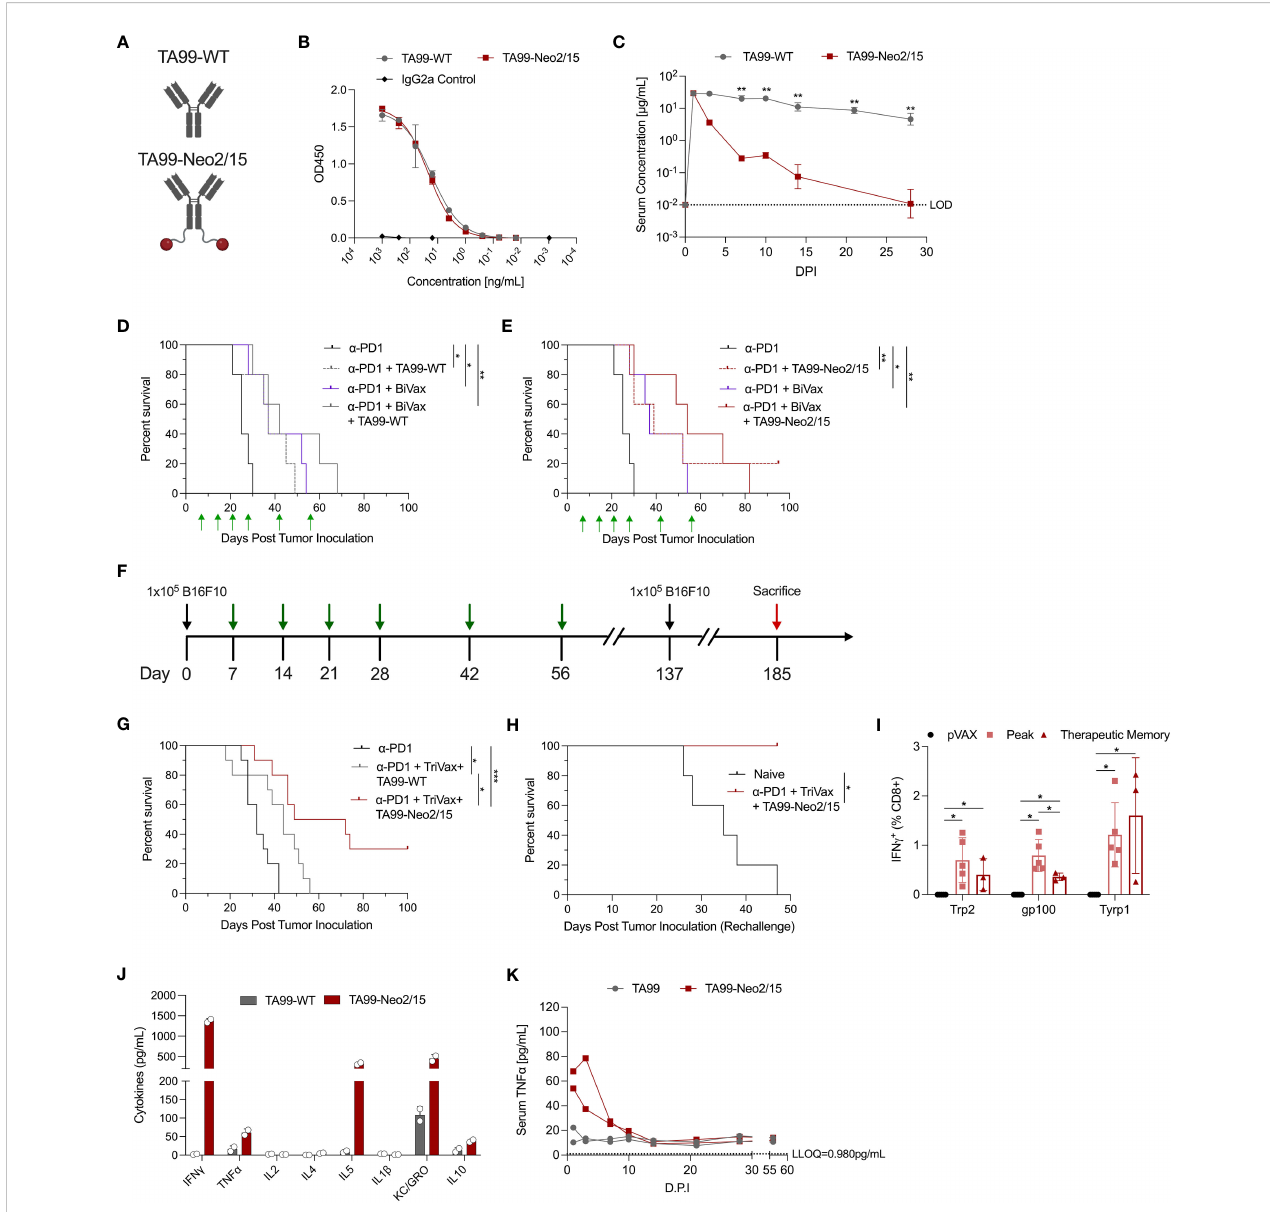
FIGURE 1 Pharmacokinetic and pharmacodynamic characterization of ACC TA99-Neo2/15. (A) Graphical representation of the TA99-WT and ACC TA99-Neo2/15; antibody is shown in grey and neoleukin Neo2/15 shown in red. (B) Binding of recombinant TA99-WT and TA99-Neo2/15 to recombinant human TYRP1 compared to a murine isotype IgG2a control. (C) Pharmacokinetic pro fi les of recombinant TA99-WT and TA99-Neo2/15 antibodies; serum at the indicated timepoints was assessed for TYRP1 binding by ELISA. (D) Survival curves of mice (n=5 per group) post tumor challenge following treatment with anti-PD1 alone (200µg), or anti-PD1 + TA99-WT (50µg), or anti-PD1 + BiVax (10µg each Trp2 and Gp100 DLnano vaccines), or anti-PD1 + TA99-WT + BiVax. 1x10 5 B16F10 cells were subcutaneously administered into the right fl ank of C57BL/6 mice. Green arrows indicate administration of treatment. (E) Survival curves of mice (n=5 per group) post tumor challenge following treatment with anti-PD1 alone, or anti-PD1 + TA99-Neo2/15 (50µg), or anti- PD1 + BiVax, or anti-PD1 + TA99-Neo2/15 + BiVax. Challenge was performed as in (D) . (F) Timeline of tumor challenge. Black arrows indicate inoculation of 1x10 5 B16F10 cells subcutaneously into the right fl ank of C57BL/6 mice. Green arrows indicate administration of treatment. Surviving mice were re-challenged subcutaneously in the opposite fl ank with 1x10 5 B16F10 cells 137 days post initial tumor inoculation. Mice that survived rechallenge were sacri fi ced (red arrow) 48 days post rechallenge for analysis of cellular responses. (G) Survival curves of mice (n=10 per group) post tumor challenge following treatment with anti-PD1 alone (200µg), or anti-PD1 + TA99-WT (50µg) + TriVax (10µg each Trp2, Gp100 and Tyrp1 DLnano vaccines), or anti- PD1 + TA99-Neo2/15 (50µg) + TriVax. 16.7% of mice distributed across all groups had palpable tumors on Day 9. (H) Survival curves following rechallenge of mice that survived the initial tumor challenge in (G) (n=3 mice) or naïve mice that also received 1x10 5 B16F10 cells at the rechallenge timepoint. (I) IFN g + CD8+ T cell responses against Trp2, Gp100, and Tyrp1 at both the peak and memory timepoints or in pVAX control vaccinated mice as determined by ICS. For determination of “ Peak ” response, C57BL/6 mice were immunized twice two weeks apart before being sacri fi ced 7 days post second immunization for assessment of cellular responses. Mice in the therapeutic “ Memory ” rechallenge in (H) (n=3 mice) were sacri fi ced 48 days post rechallenge for assessment of cellular responses. (J) Assessment of proin fl ammatory cytokines in two pools of mice sera Day 1 post administration of 100µg recombinant TA99-WT or TA99-Neo2/15. (K) Timecourse of serum TNF a levels in sera of mice administered antibody constructs as in (J) . Two pools of sera were used for panels (J, K) . Error bars represent standard deviation; non-parametric Mann-Whitney T test used to compare groups in (C, I) ; log-rank test was used to compare between differences in all survival curves. The anti-PD1 and anti-PD1 + BiVax groups are duplicated on panels (D, E) for clarity. *p < 0.05, **p < 0.01, ***p <